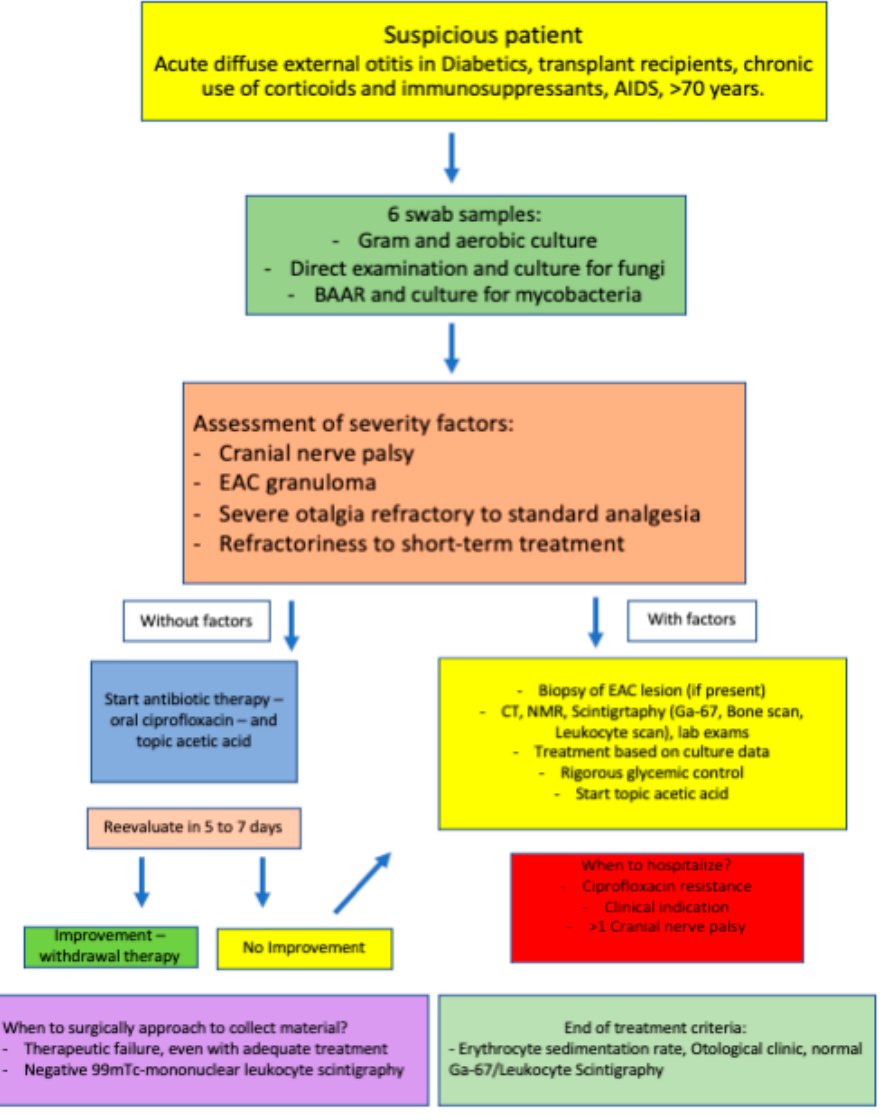
Figure 1. Suspected NEO patient management .